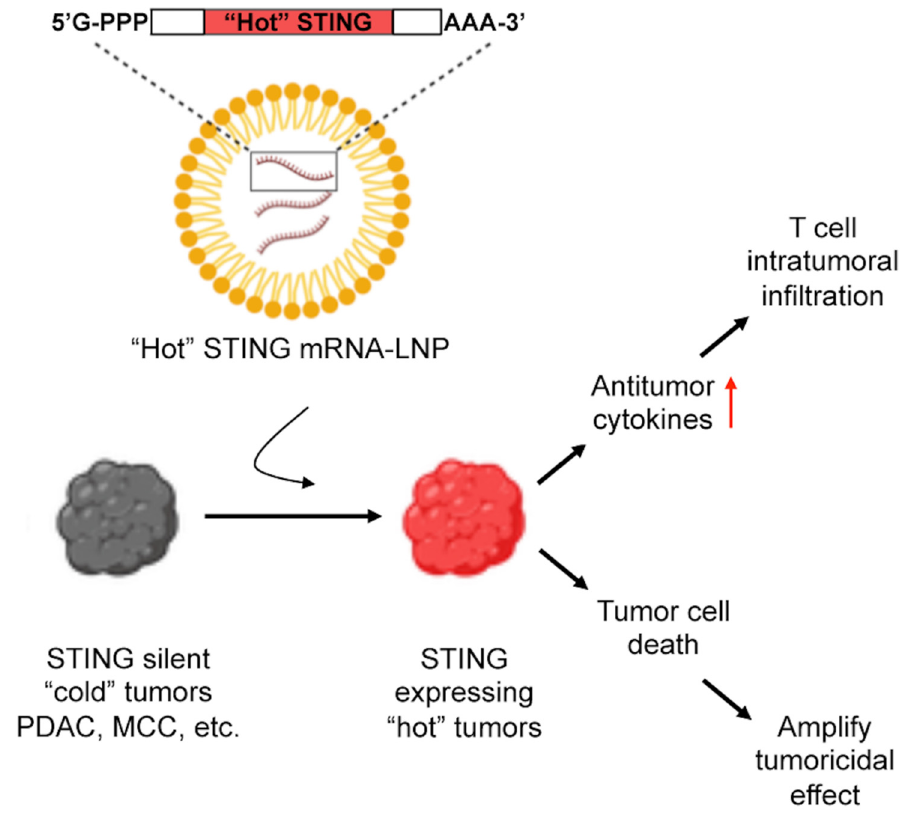
Figure 7. Applying “hot” STING mRNA-LNP to stimulate antitumor immunity in STING-deficient tumors. mRNA encoding constitutively active gain-of-function “hot” STING genetic mutants derived from autoinflammatory diseases can be delivered with LNP into STING silent “cold” tumors, such as PDAC and MCC, to induce STING downstream cytokines and chemokines that are crucial for promoting intratumoral infiltration of CD8 + T cells. Expression of “hot” STING also causes robust killing of the tumor cells, exposing tumor neoantigens to the host immune system to amplify the tumoricidal effect. This process could also stimulate adaptive antitumor immunity for rejecting distant metastases and establishing long-living immunologic memory.